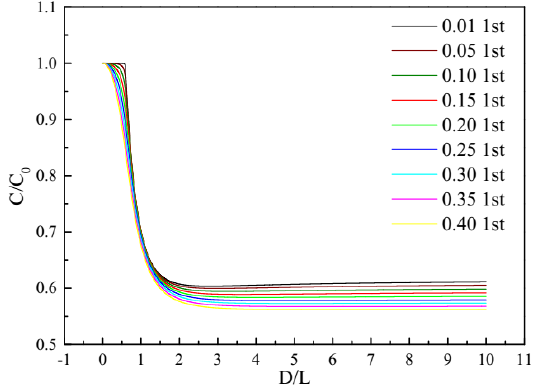
Figure 2. The first- order phase velocity curves of different Poisson’s ratio .